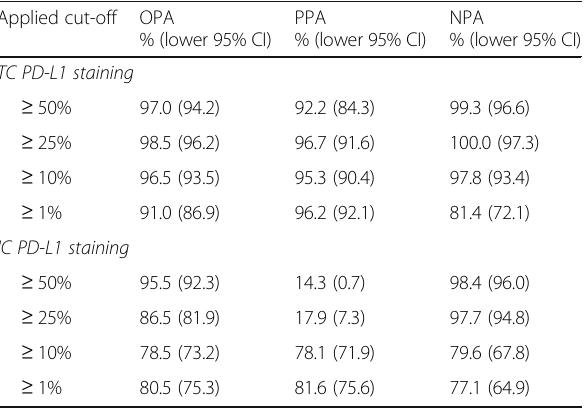
Table 4 Intra-block concordance (OPA; PPA; NPA) in PD-L1 classification of NSCLC samples at various applied